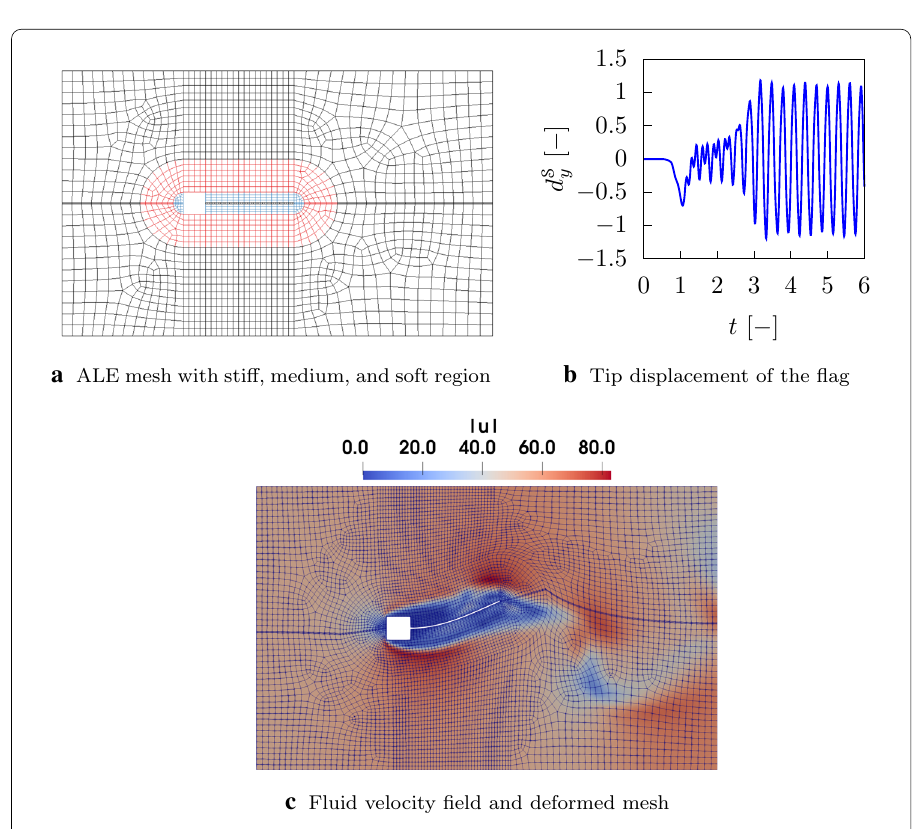
Fig. 10 Topleft: Mesh with stiff, medium, and soft ALE regions colored in blue, red, and black, respectively. Topright: Tip displacement of the flexible flag over time: the amplitude is larger than half the flag length, indicating large deformations. Bottom: Fluid velocity field and deformed mesh at state of maximum deflection at time t = 4 . 39